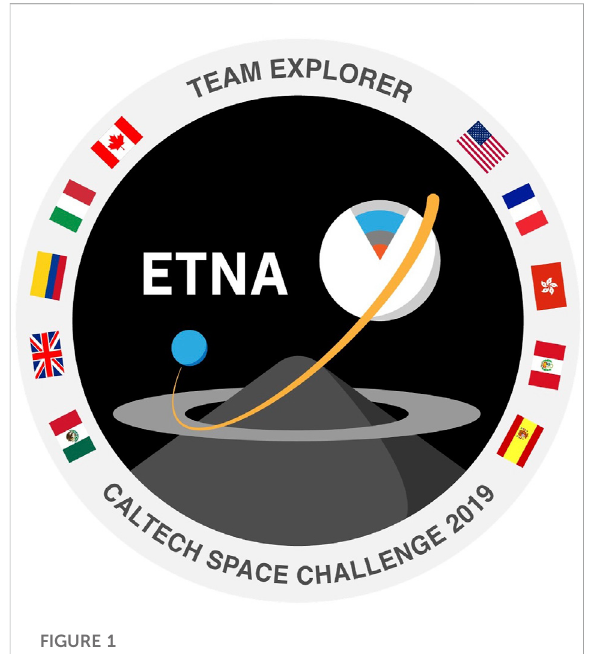
FIGURE 1 The Enceladus Touchdown aNalyzing Astrobiology (ETNA) mission was designed by our team of 16 students representing eight different countries. Mission patch and artwork designed by Sam